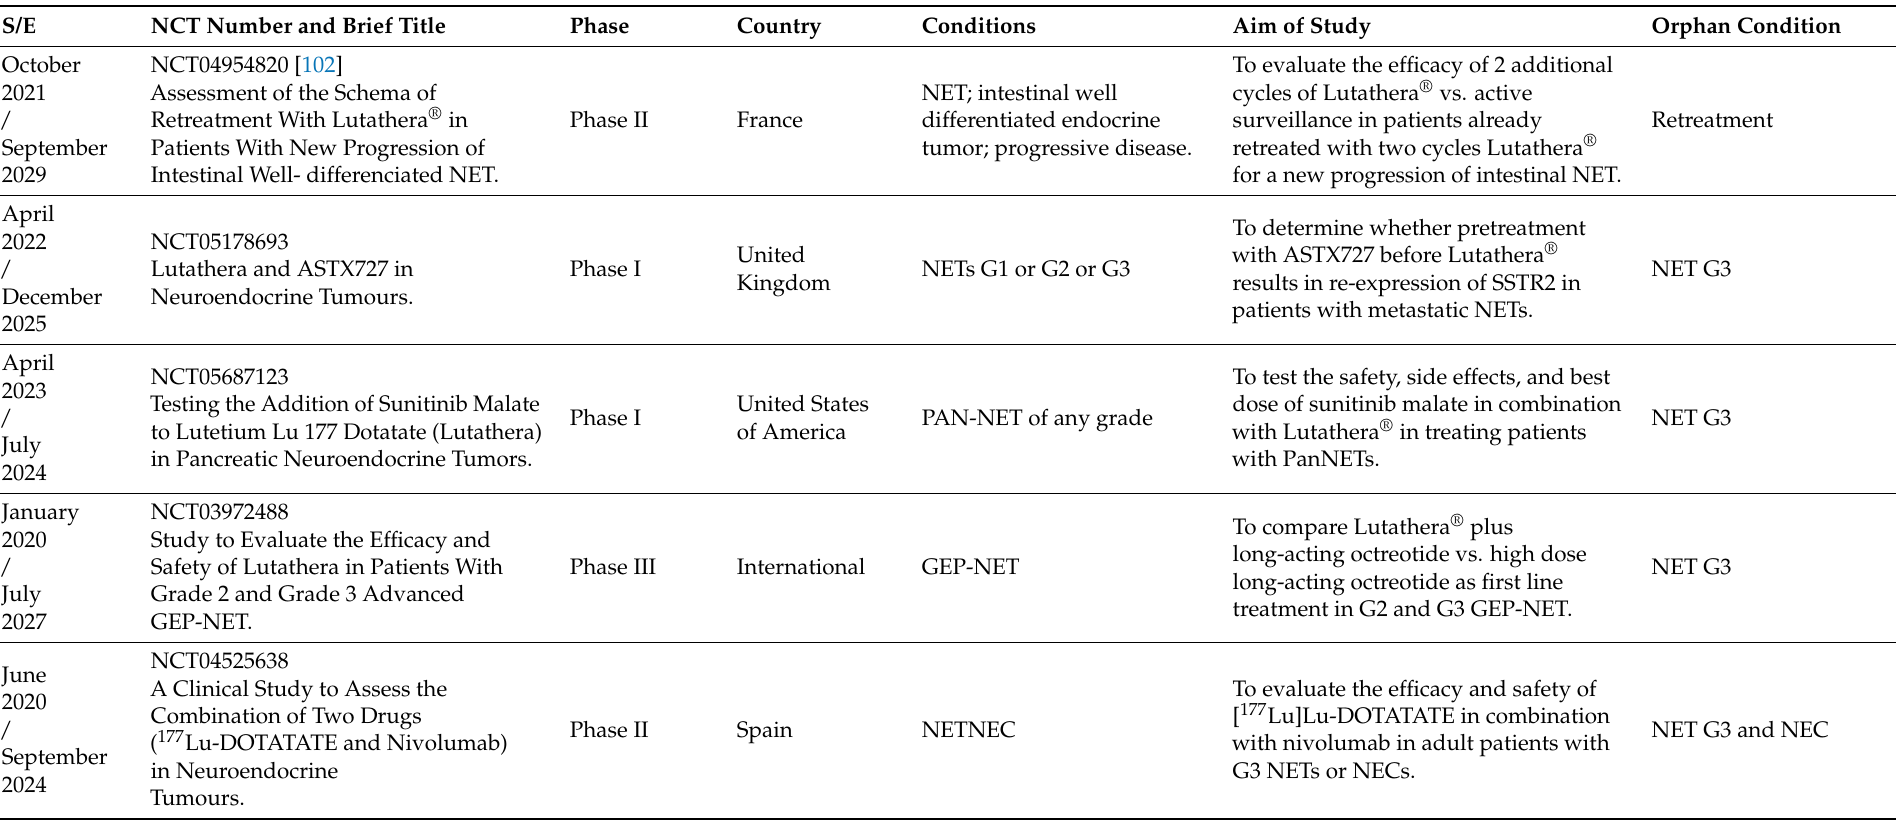
Table 2. Ongoing clinical trials assessing [ 177 Lu]Lu-DOTATATE RLT in “Lutathera ® Orphans”. The short title shown in the table; to facilitate any consultation, this is the original title entered by the experimenters on the site and not modified, even where not formally